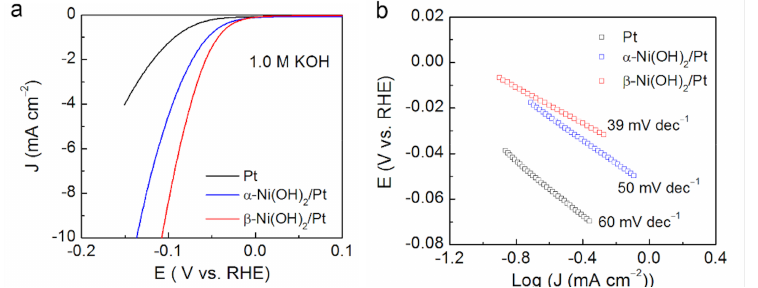
Figure 1. ( a ) Linear sweep voltammograms of Pt, α -Ni(OH) 2 /Pt, and β -Ni(OH) 2 /Pt in KOH 1M at 10mVs − 1 . ( b ) Tafel plots corresponding to the voltammograms in ( a ) from